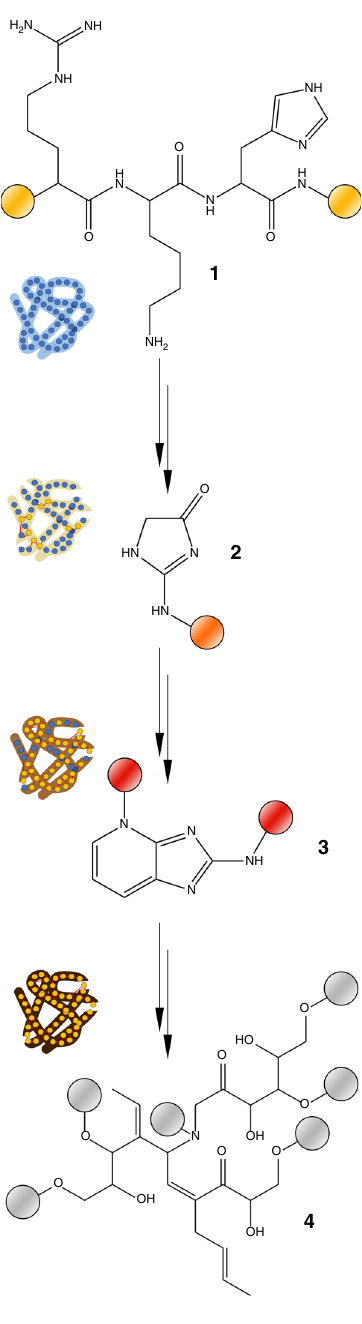
tissue. All extracted fossil soft tissue samples were immediately subjected to Raman Microspectroscopy ( n = 15). Modern hard tissue decalci fi cation residues were treated in the same way as the fossil samples. Small aliquots of modern sample decalci fi cation residues were subjected to experimental maturation at different temperatures and incubation times, followed by Raman Microspectroscopy.